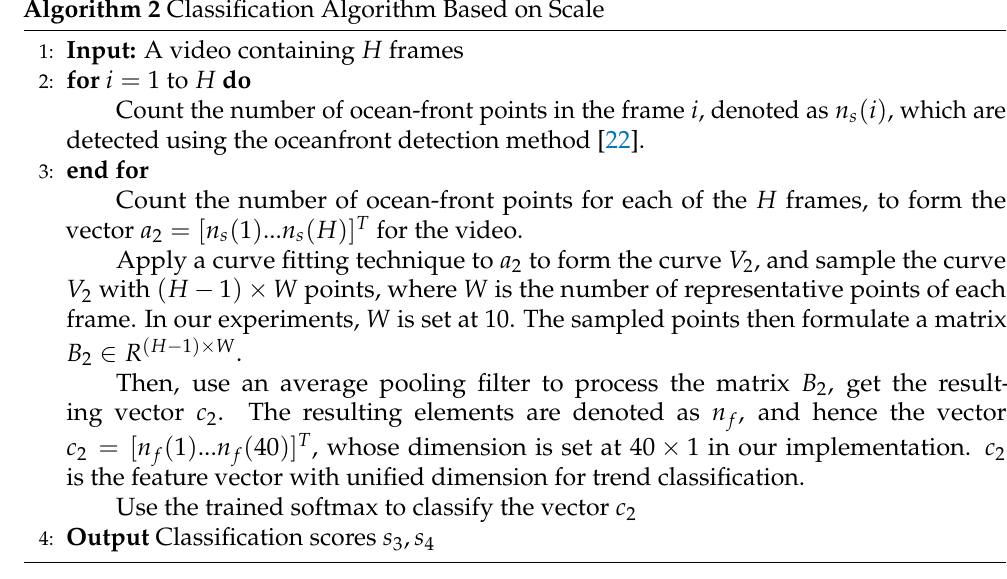
Algorithm 2 Classification Algorithm Based on